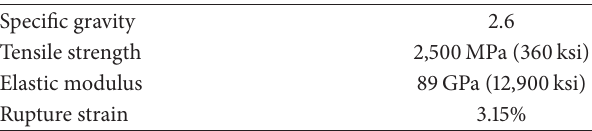
Table 2: Basalt fiber sheet properties.